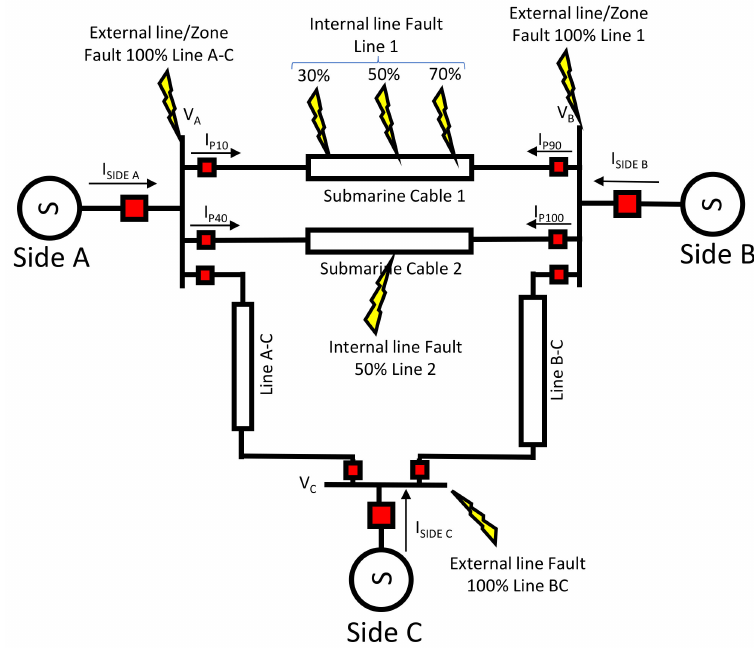
Figure 20. Fault locations in 150 kV transmission system.